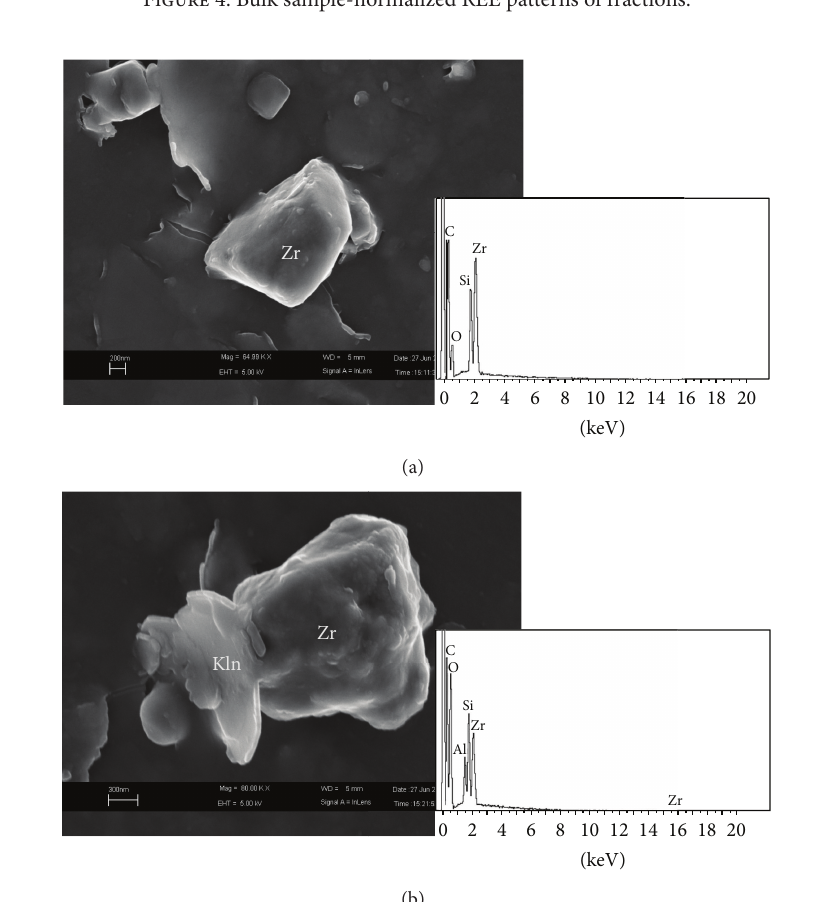
Figure 4: Bulk sample-normalized REE patterns of fractions.